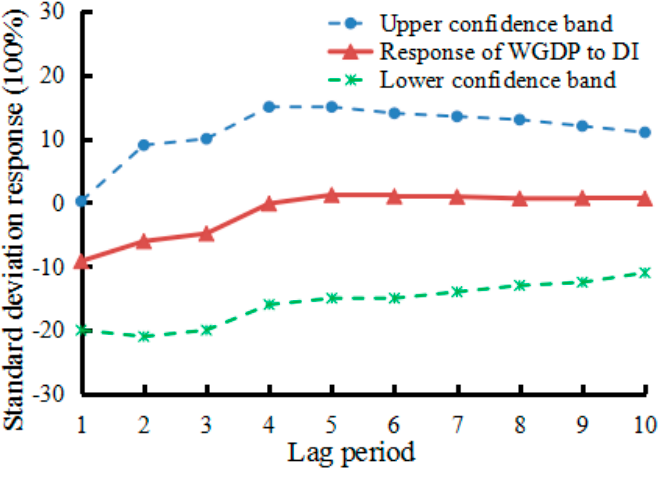
Figure 2. Standard deviation response of WGDP to DI.